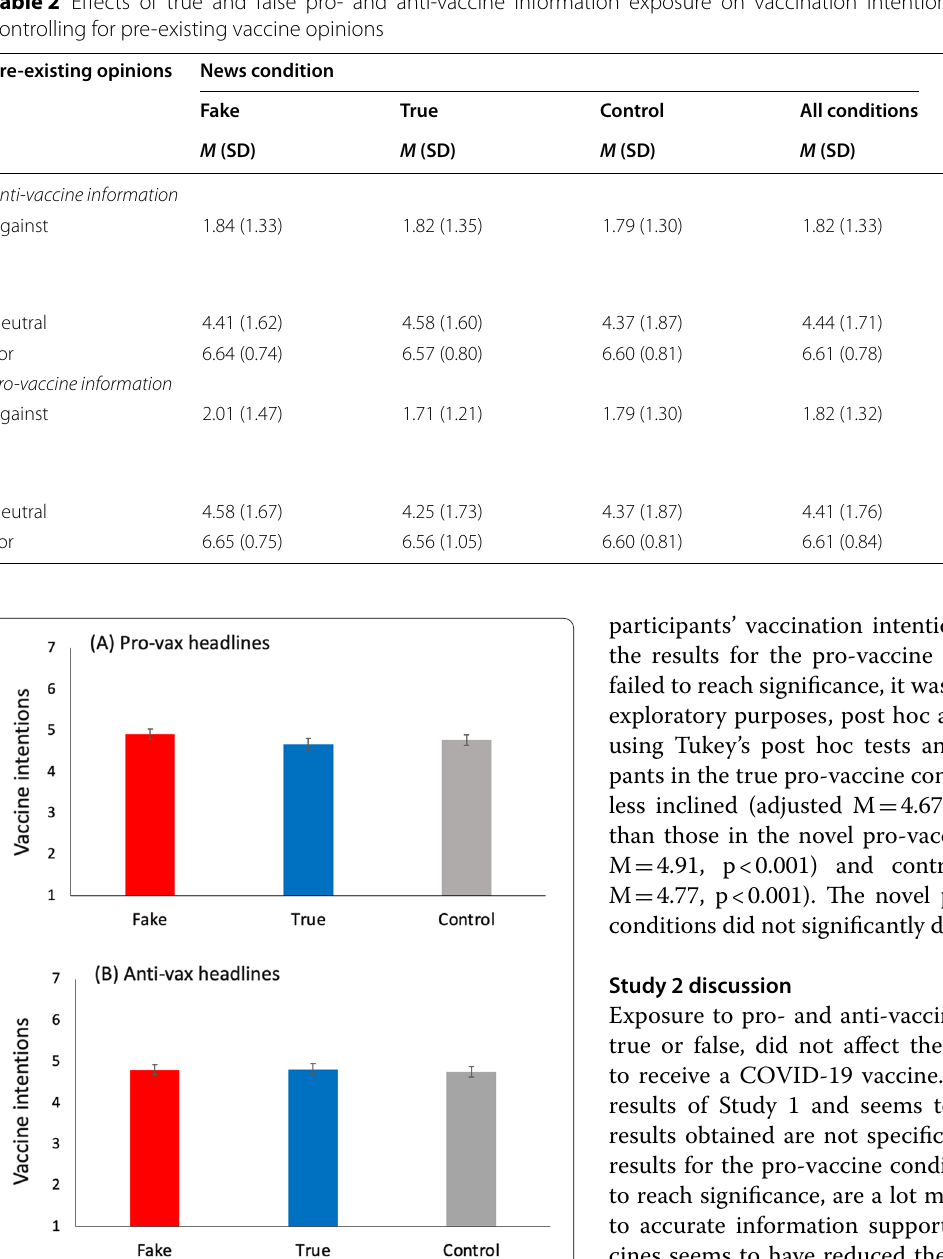
Fig. 3 Vaccination intentions in Study 1 and Study 2 following exposure to A true and false pro-vaccination headlines and B true and false anti-vaccination headlines. Mean values are adjusted for pre-existing vaccine opinions. Error bars represent 95% confidence